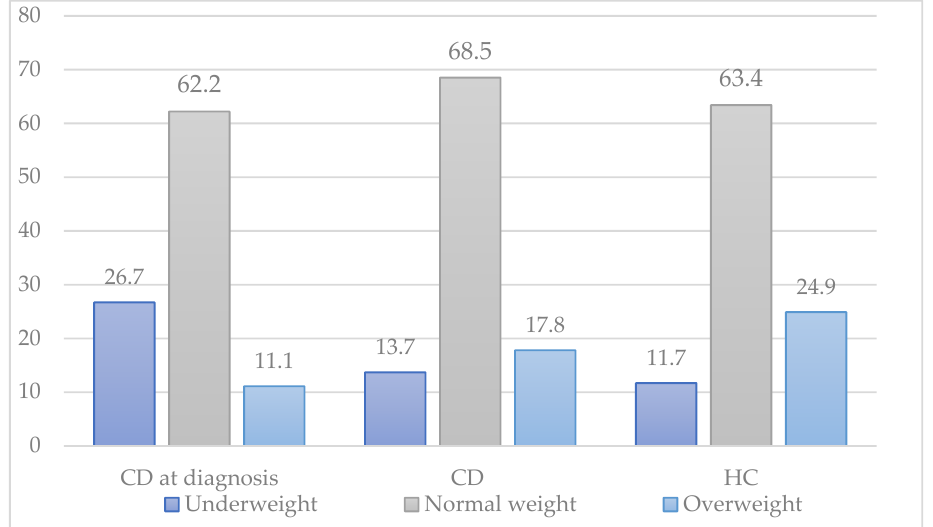
Figure 1. Distribution of underweight, overweight, and normal weight of CD patients at diagnosis (CD at diagnosis), CD patients during GFD (CD), and healthy controls (HC).